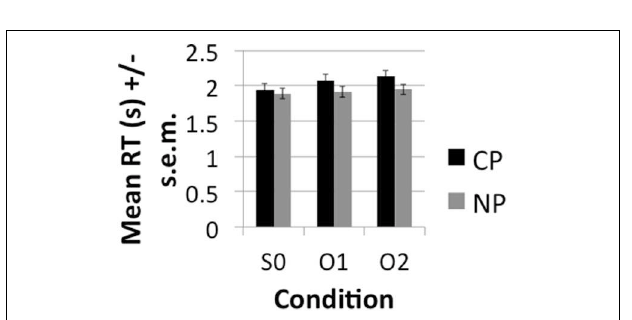
FIGURE 3 | Mean Reaction Time (RT) in seconds (s) ± s.e.m. to comprehension question broken down by condition.